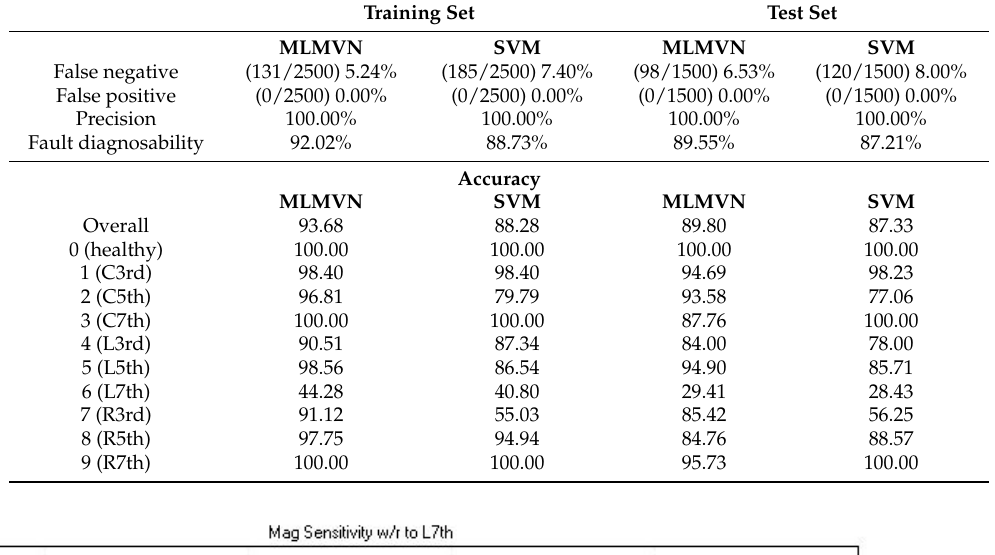
Table 5. Fault classification results in a network filter with no evaluation of the response.